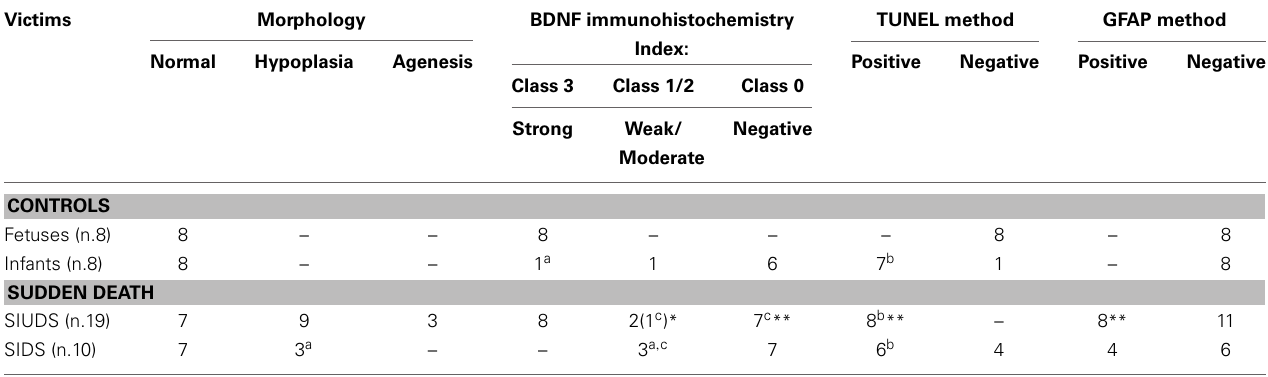
Table 2 | Morphological and immunohistochemical findings related to KFN in SIUDS/SIDS and Controls.